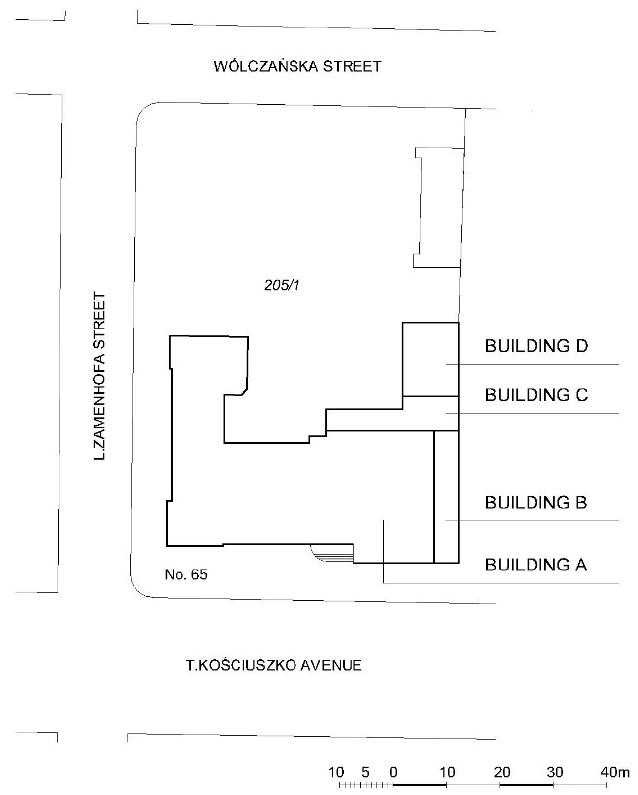
Figure 4. Site: the current layout of the building.